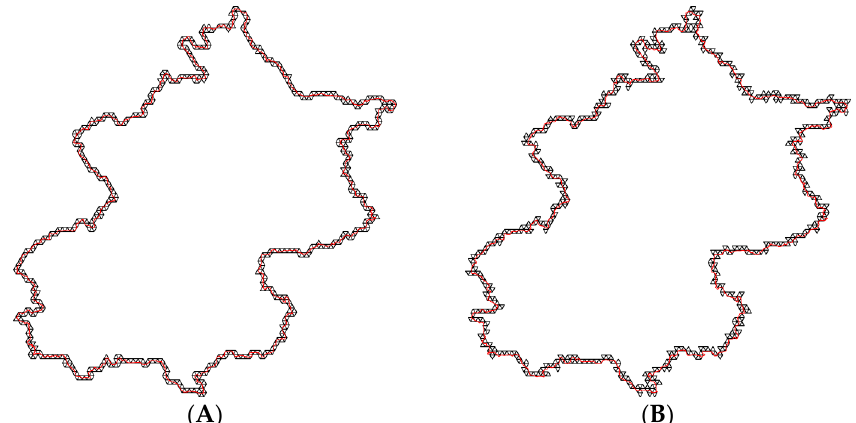
Figure 10. Comparison of the overall effectiveness of the two algorithms (side length of grid cells is approximately 3 km): ( A ) discrete line of Beijing boundary generated by the proposed algorithm and ( B ) discrete line of Beijing boundary generated by the Freeman algorithm.